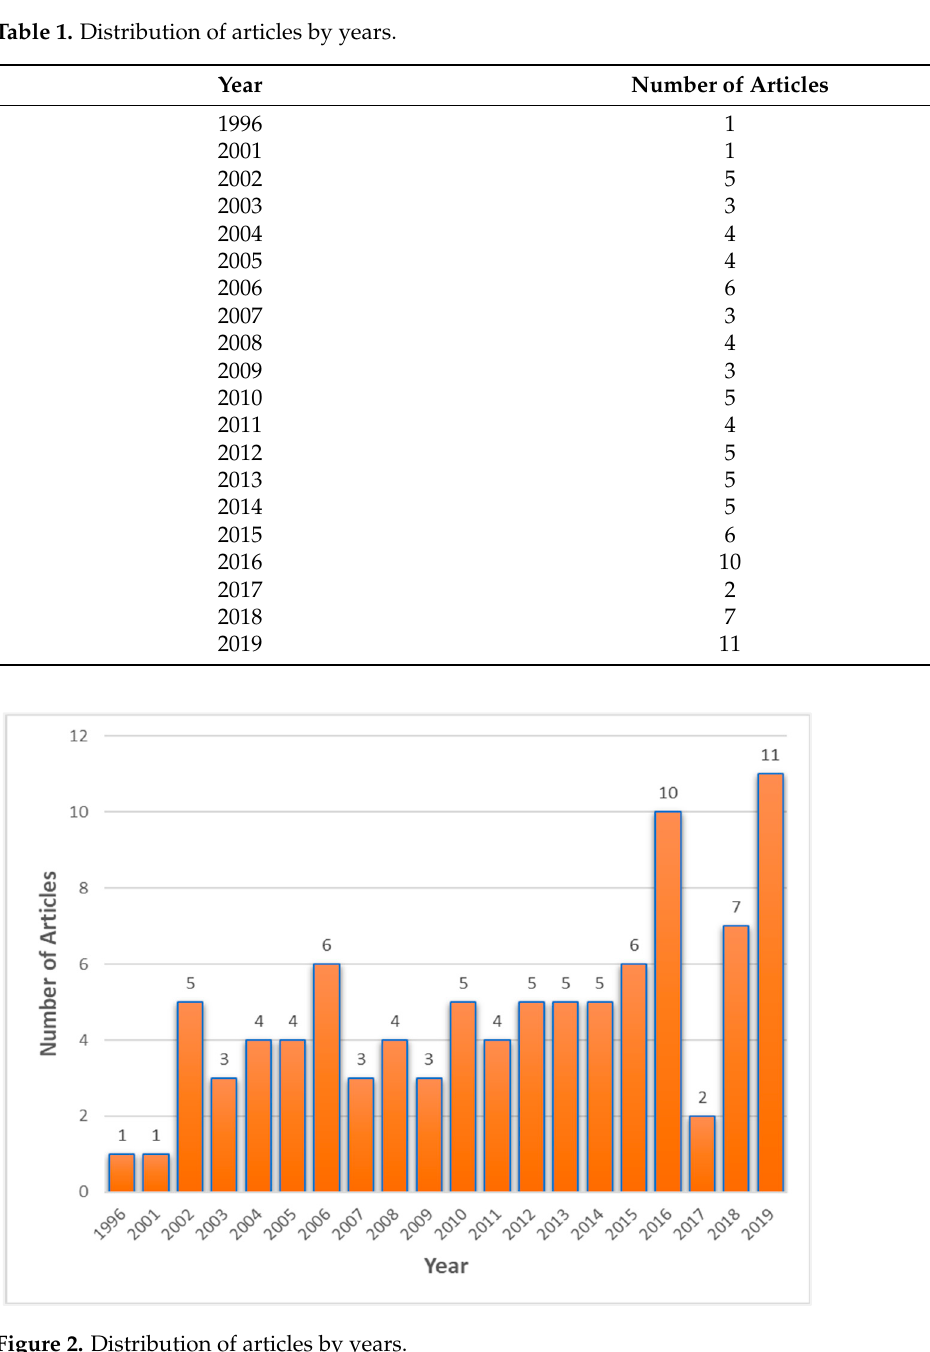
Table 2. Most Cited Articles.